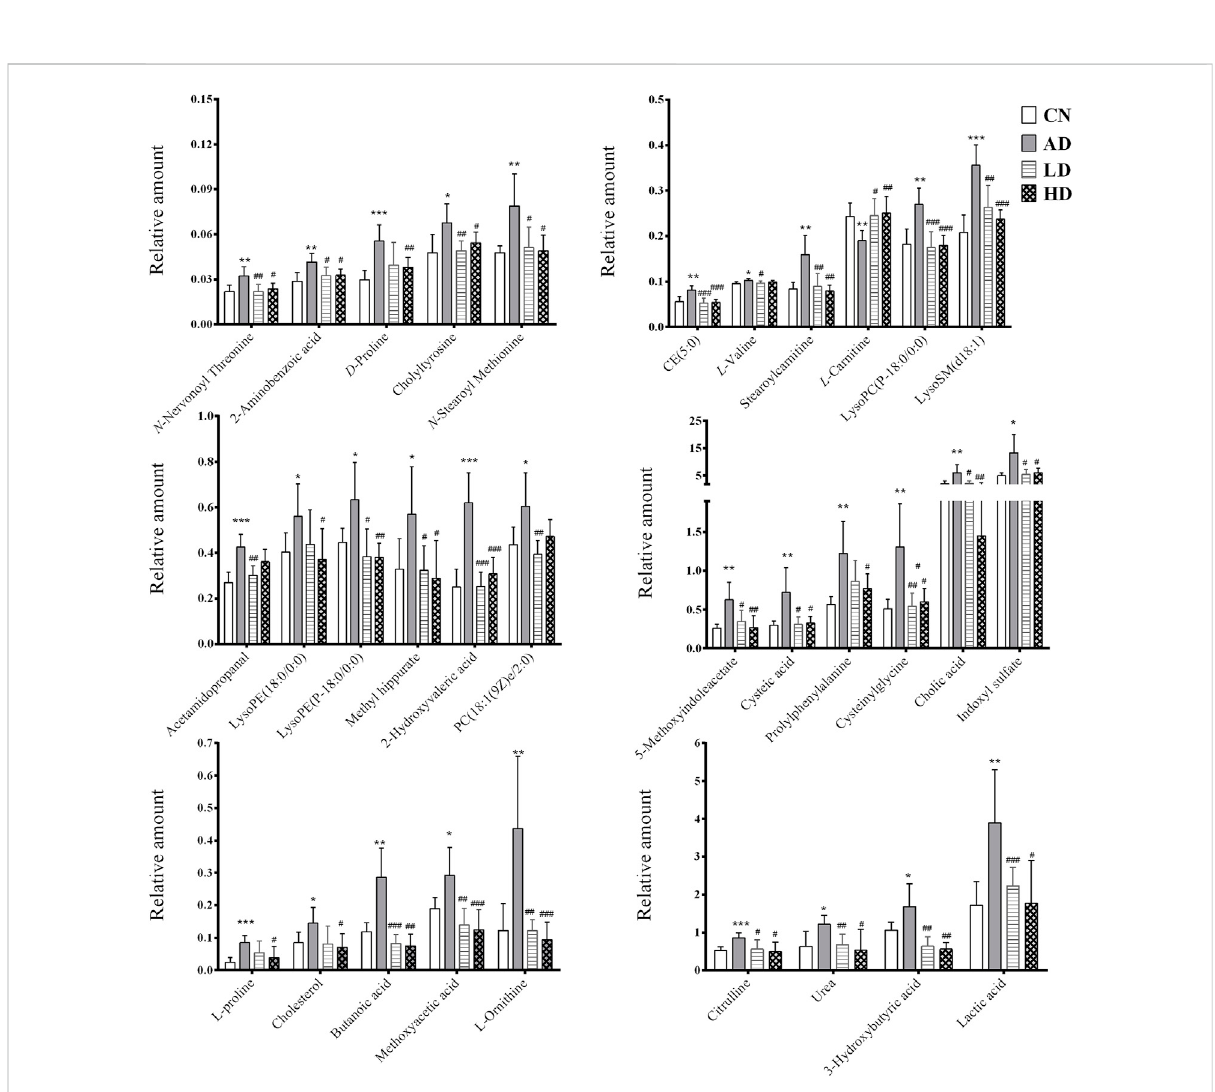
FIGURE 8 Potential biomarkers associated with AR pre-treatment in rat serum in positive mode of LC-QTOF/MS, negative mode of LC-QTOF/MS, and GC-MS. * p < 0.05, ** p < 0.01, compared with CN group; # p < 0.05, ## p < 0.01, compared with AD group.